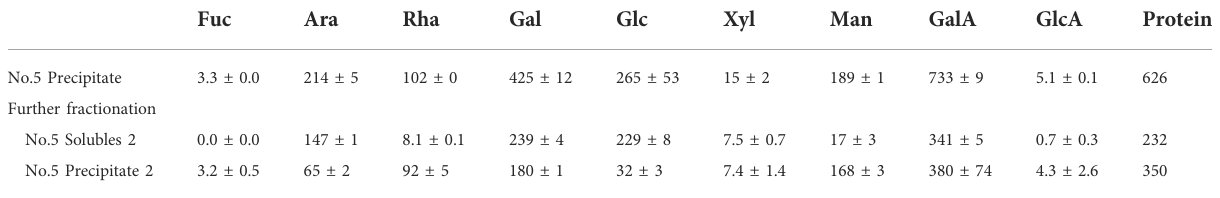
TABLE3Monosaccharidecompositionofextractedpolysaccharides(No.5.IPAprecipitate,Table1)andthesoluble(solubles2)andinsolublefraction (precipitate 2) results from an additional treatment with 60% IPA (IPA) on the obtained pectin-rich polysaccharide fraction. The weight of the monosaccharides is provided if they were dehydrated in mg/20 g DW destarched pulp. The values are the average of three independent measurements, including the standard deviation of the three.